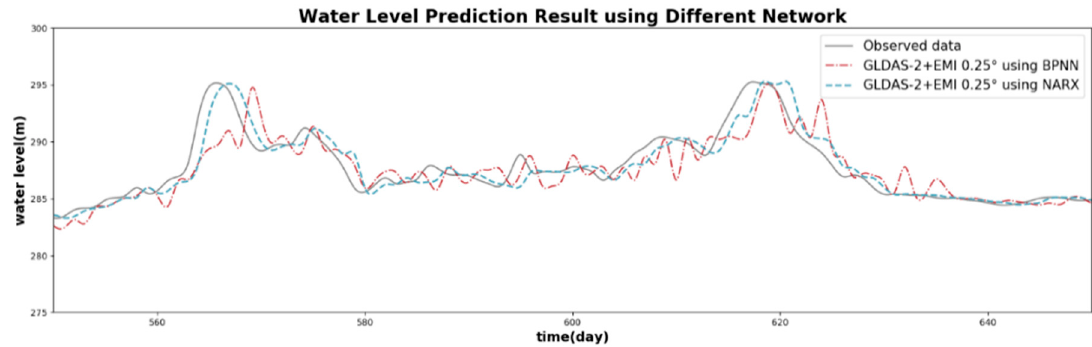
ff erent neural network